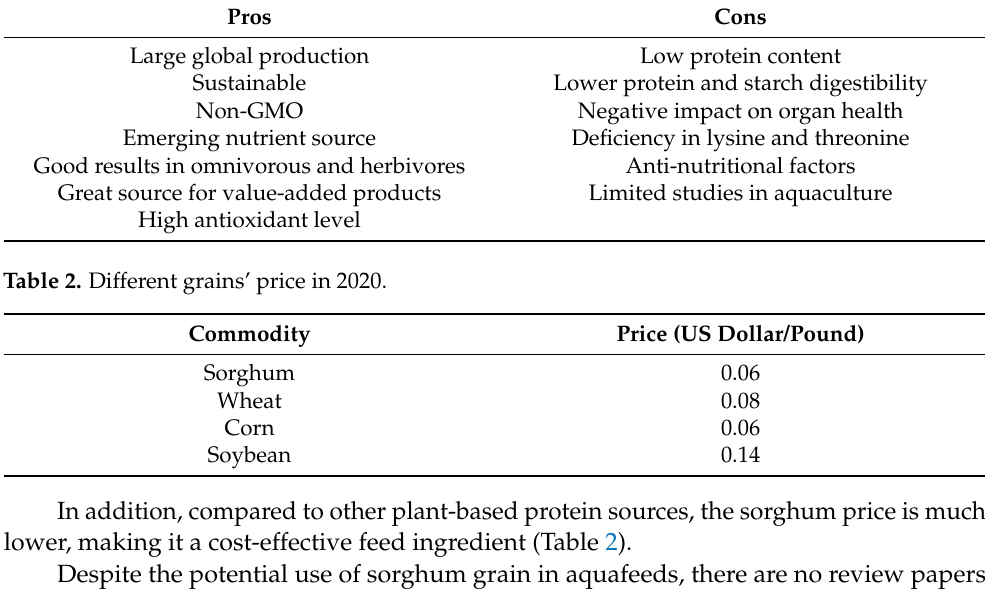
Table 1. A summary of sorghum pros and cons for aquafeed development [2,4–6,8,9,11,18,23]. Pros Cons